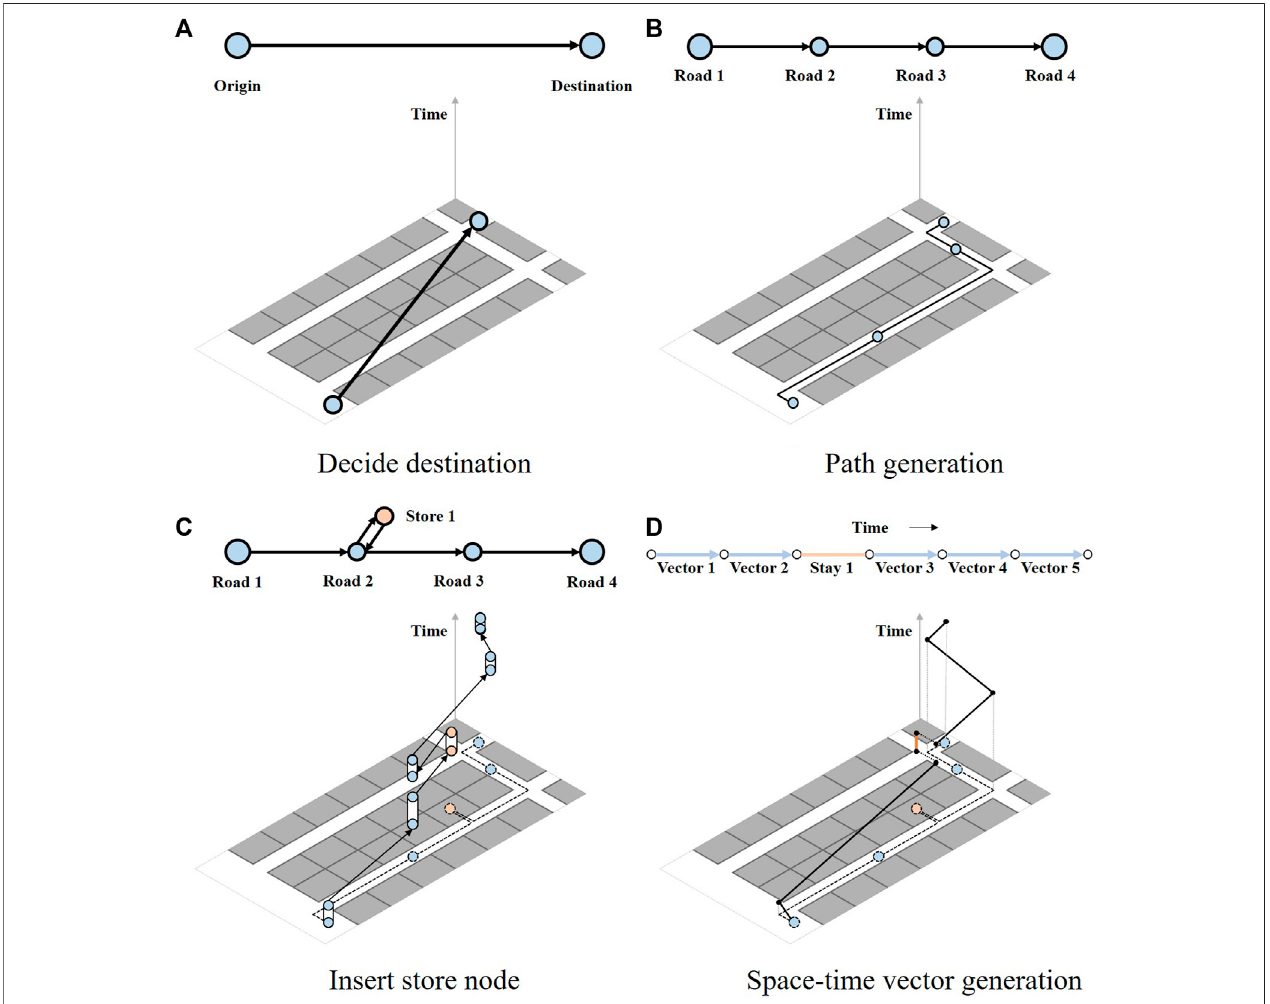
FIGURE 5 | Spatiotemporal path generation.